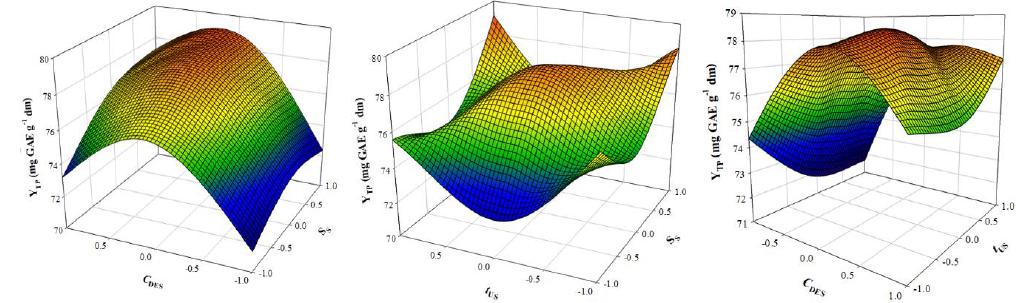
Figure 5. The effect of independent variables on the response (Y TP ), illustrated as three-dimensional